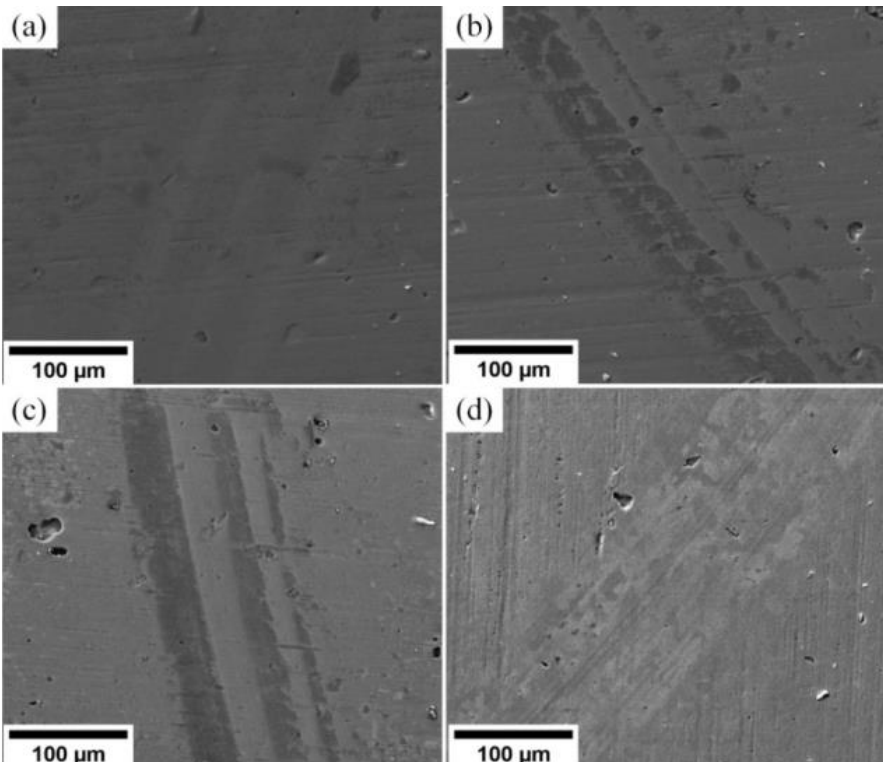
Figure 11. Wear tracks on the surface produced by Al 2 O 3 counter body for substrates: ( a ) S1 (Al/Cr = 1.2), ( b ) S2 (Al/Cr = 0.8), ( c ) S3 (Al/Cr = 0.5), ( d ) S4 (Al/Cr = 0.2).